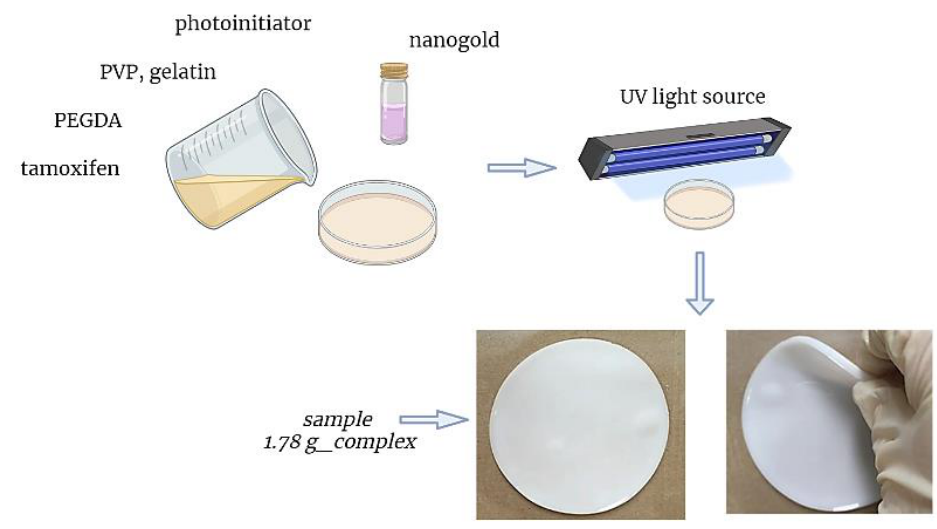
Figure 1. Scheme of synthesis of hydrogel materials.